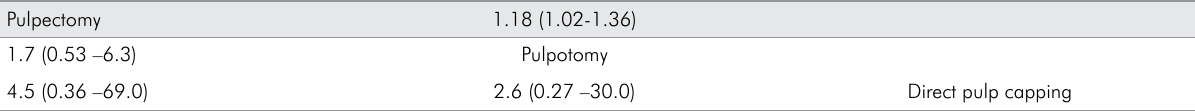
Table 4. League table with all direct* (gray) and mixed** (white) comparisons of treatments for accidental pulp exposure in the presence of vital